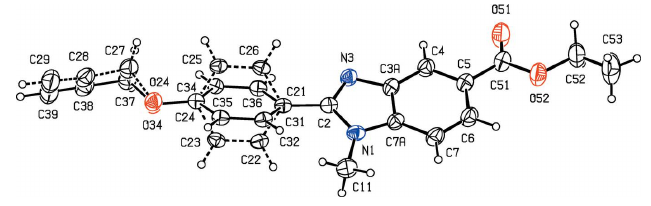
Figure 1 The molecular structure of compound (I) showing the atom-labelling scheme and the disorder. The major disorder form is drawn using full lines and the minor disorder component is drawn using broken lines. Displacement ellipsoids are drawn at the 30% probability level.